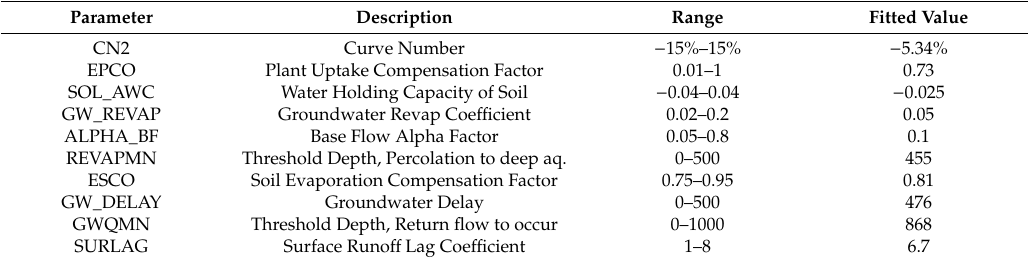
Table 2. List of parameters used for calibration with their ranges and the fitted value.